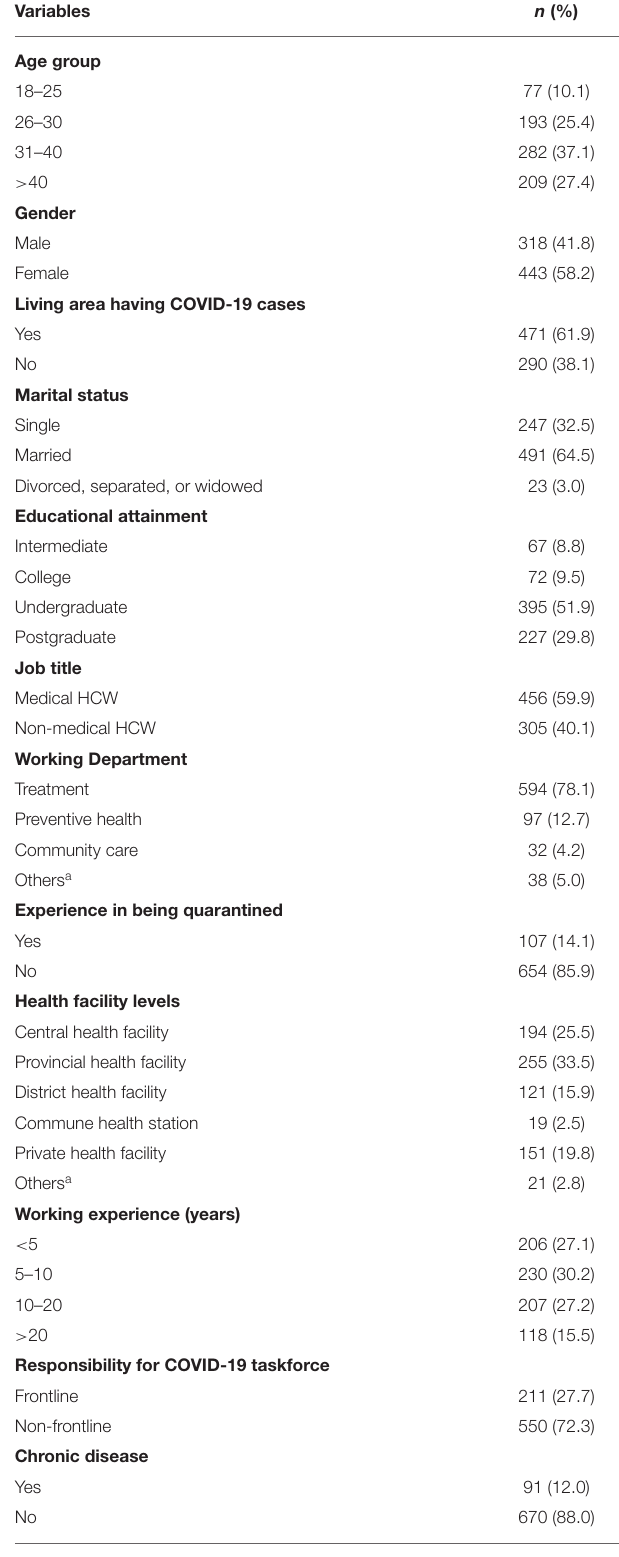
TABLE 1 | Socio-demographic characteristics among HCWs during the COVID-19 outbreak in Vietnam ( n = 761).